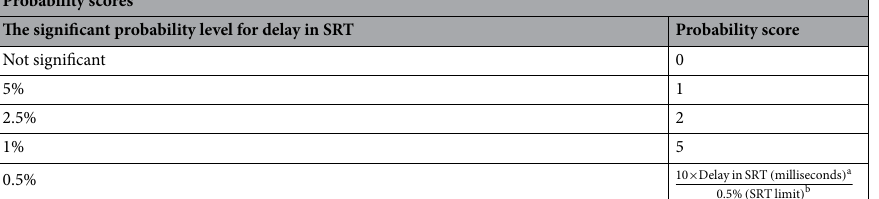
Table 1. The probability score (PS) assigned for SRT delayed at each probability levels. a Delay in SRT is the residual SRT after subtracting the SRT raw value from the age matched normal reference value for that particular location. b SRT limit is the expected age corrected SRT value for that location at the probability level of 0.5%. SRT indicates saccadic reaction time in milliseconds.